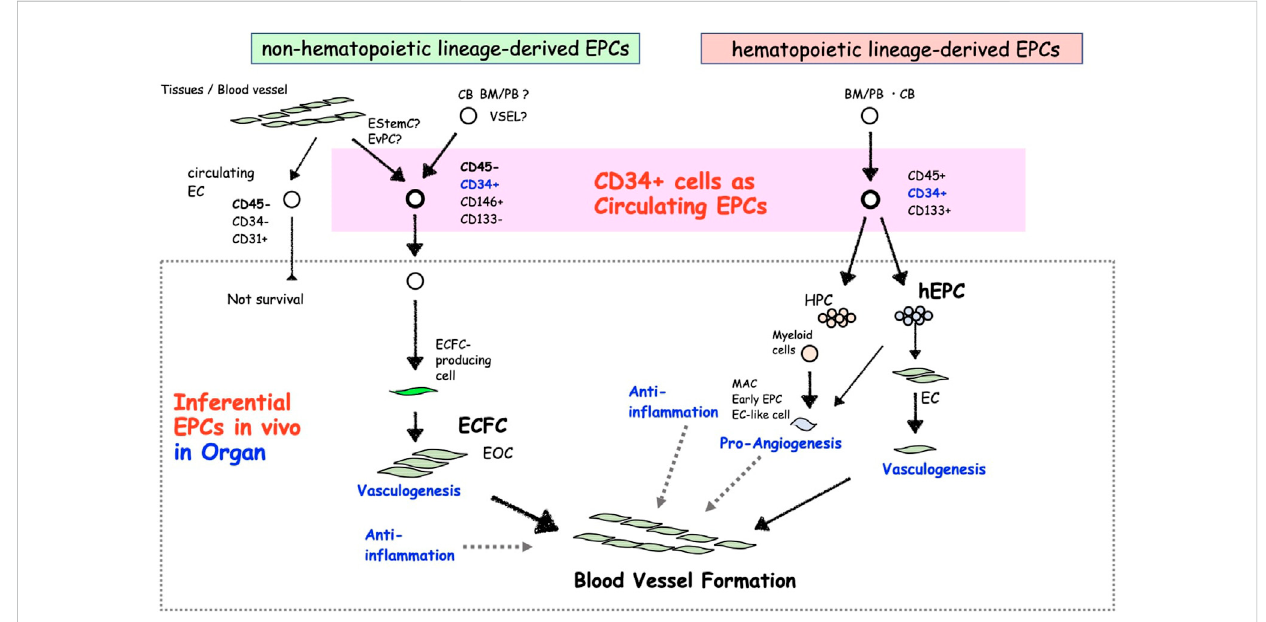
FIGURE 1 The concept of different CD34 + EPC types and their